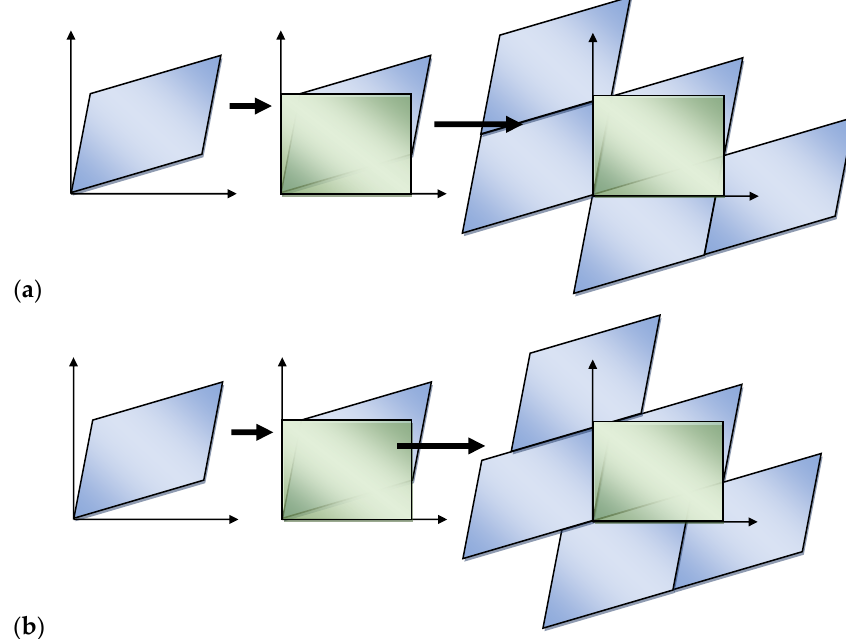
Figure 15. Replacement of the distorted cellular automata space with periodic boundary conditions through a rectangular space: ( a ) periodic conditions without displacement, ( b ) periodic conditions with displacement.